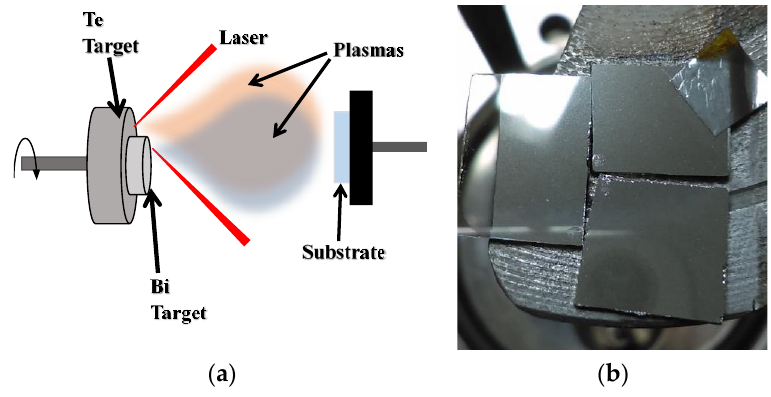
Figure 1. ( a ) PLD system configuration. ( b ) Deposited films.